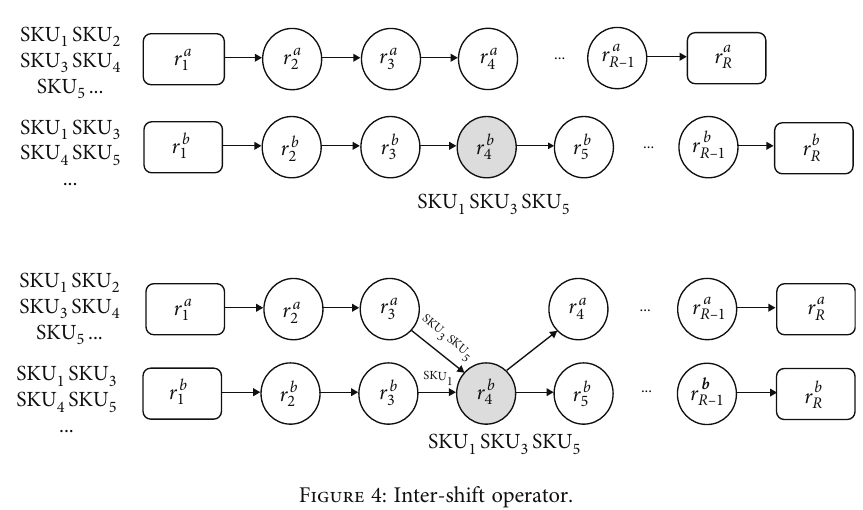
Figure 3: Inter-swap operator.